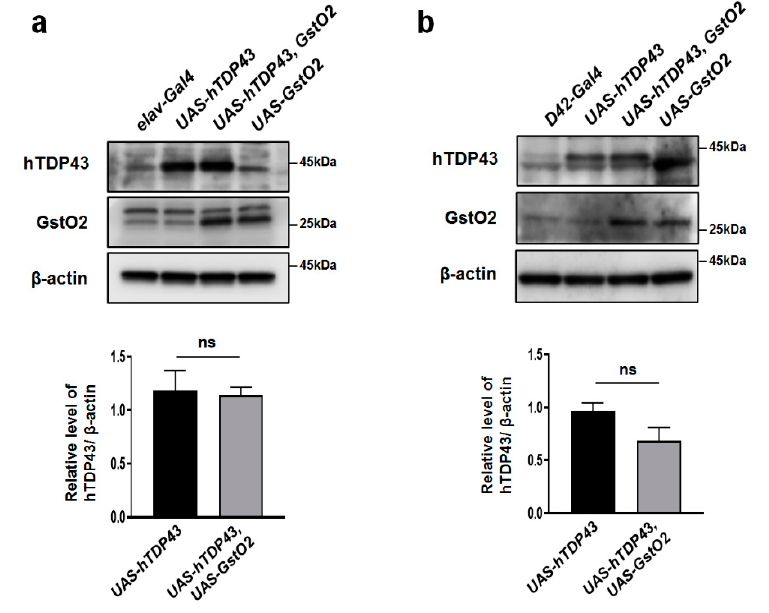
Figure 4. The level of hTDP-43 protein had no effect on pan or motor neurons after GstO2 overexpression. ( a ) Overexpressing GstO2 in pan neurons with elav-Gal4 did not affect the hTDP-43 protein level. ( b ) The up-regulation of GstO2 using motor neuron-specific D42-Gal4 driver also had no effect on the hTDP-43 protein expression level. β -actin was used as a loading control. The hTDP-43 expression level was normalized to β -actin. Statistical significance was determined using the unpaired S tudent t -test (ns, not significant). Error bars indicate SEM of three independent experiments.